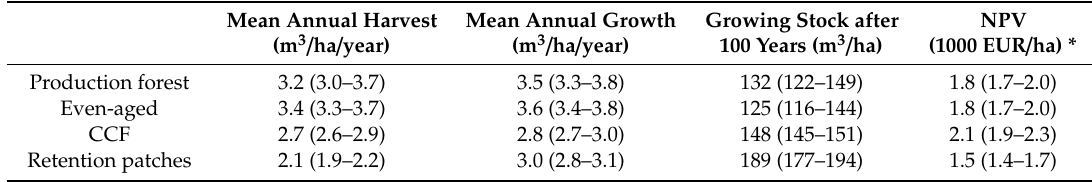
Figure 4. Development of absolute net growth, harvest volumes and growing stock over time for the four stakeholder scenarios. Only production forest, i.e., excluding reserves. Table 4. Mean (and range, in brackets) of the economic indicators in the production forest and specified per management regime across the stakeholder scenarios. Forests in reserves were left unmanaged without any wood extraction, and are therefore not included.